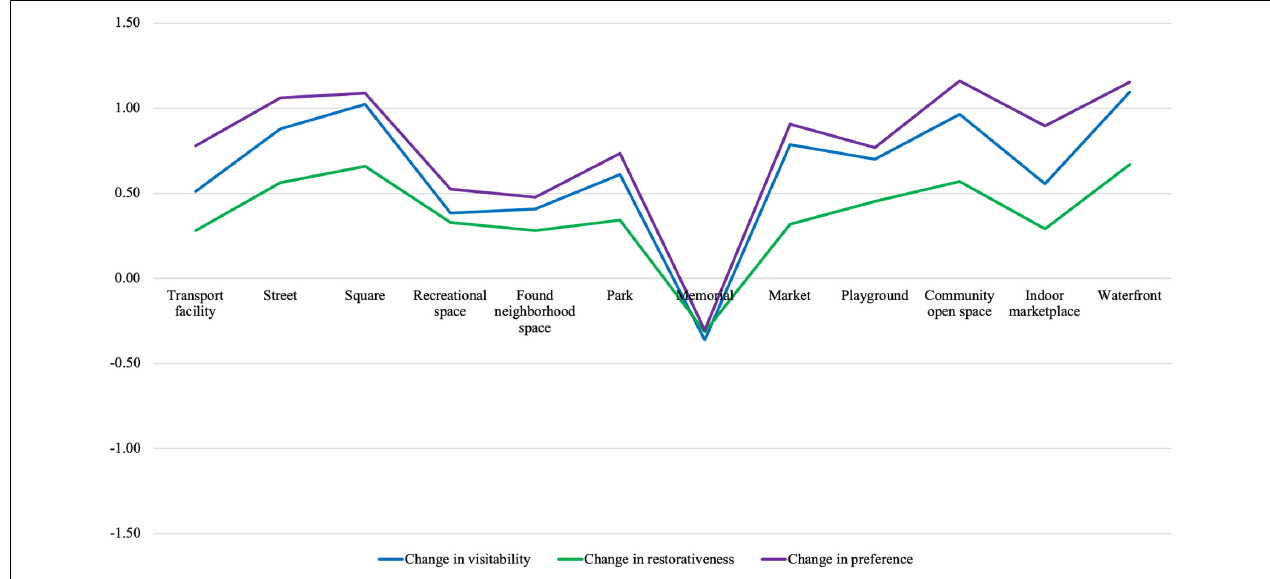
FIGURE 3 | Effects of street performance across the 12 public